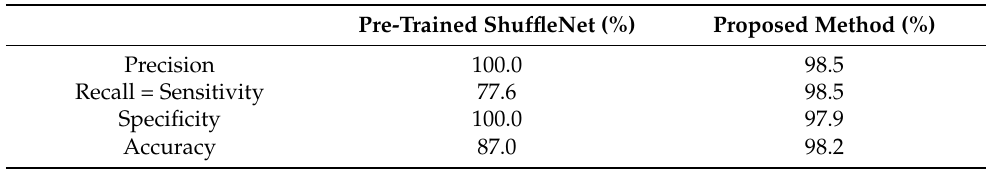
Table 3. Results based on precision, recall, specificity, and accuracy matrices for the pre-trained ShuffleNet and proposed method.